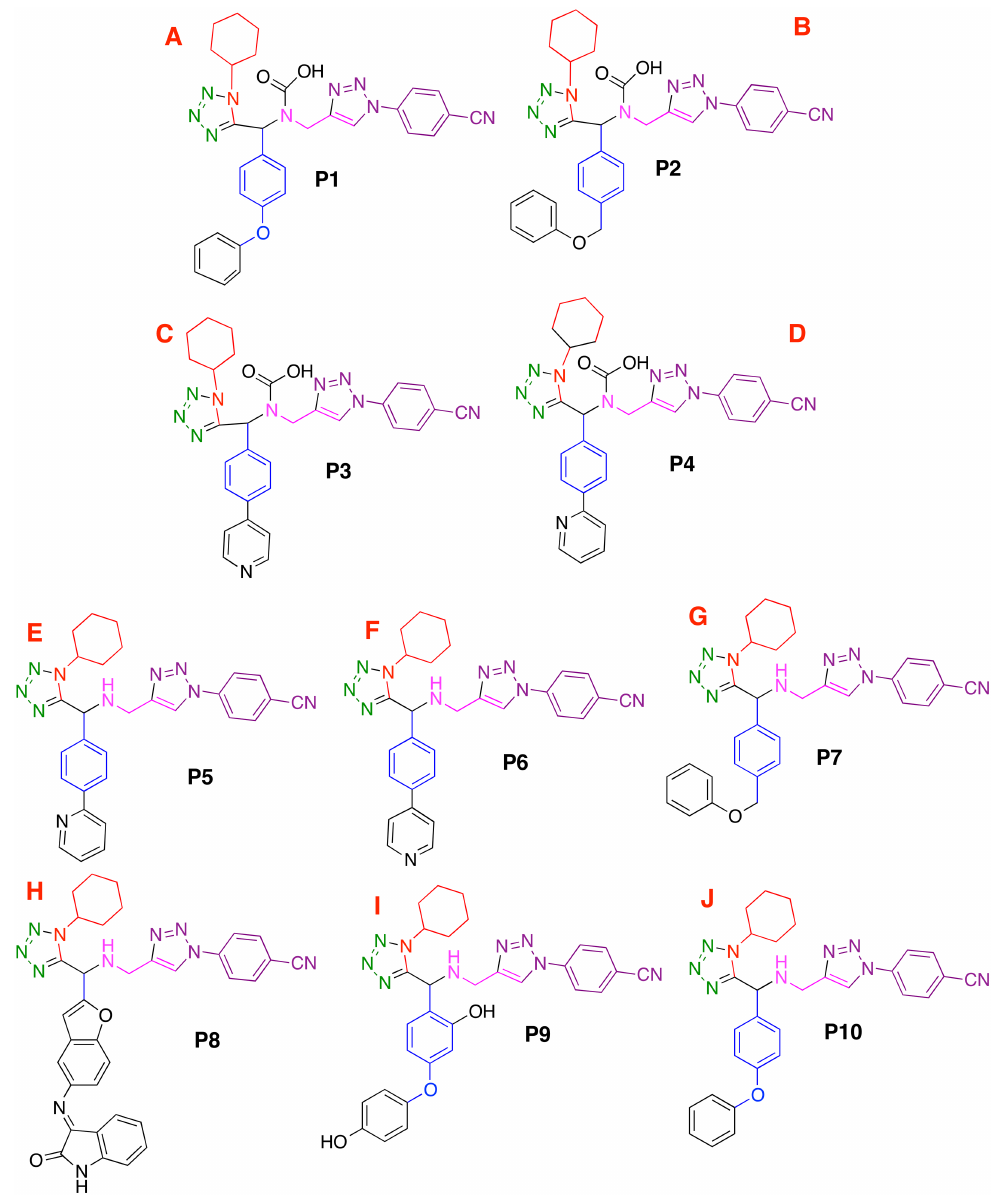
Figure 7 Designed compounds that present favorable interactions with the CoV-2-M Pro protein. (A – J) Compounds presenting structural variation in their R's